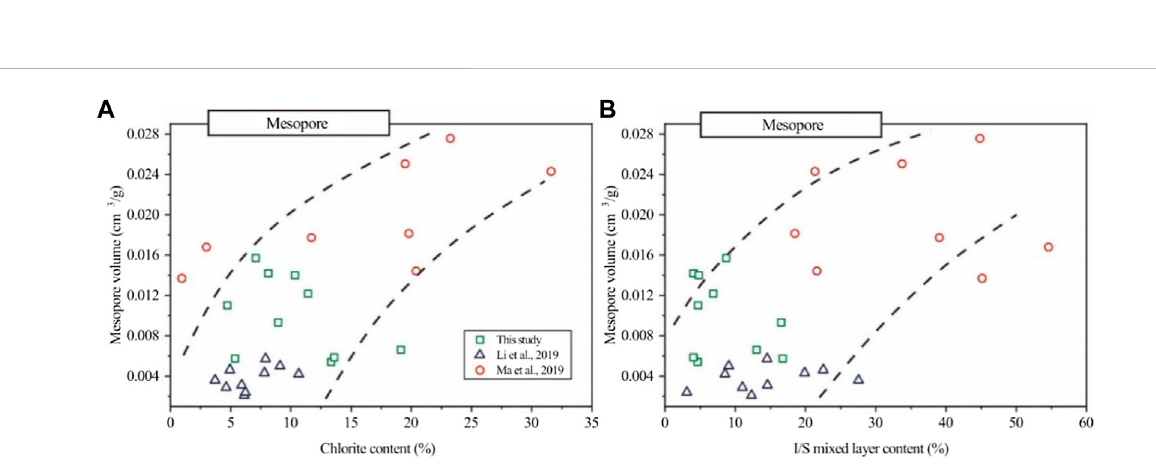
FIGURE 9 Correlation between total clay mineral content and pore volume in the marine-continental transitional shale in different regions.